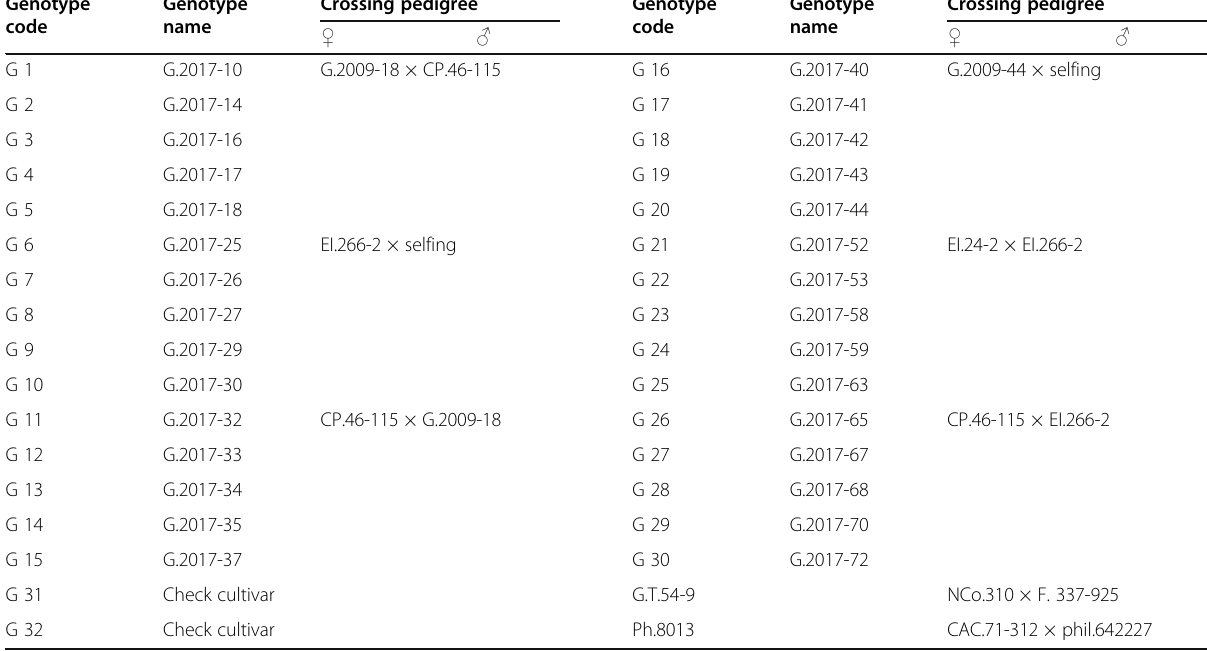
Table 1 Genotype code, pedigree of the studied sugarcane genotypes Genotype